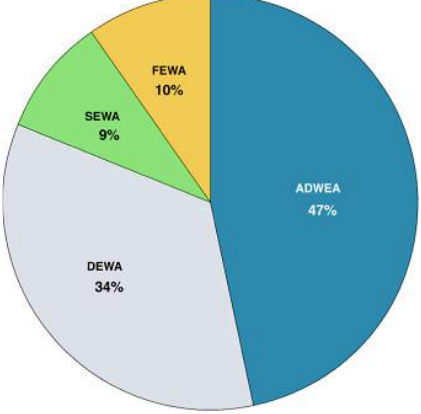
Figure 4. Annual electrical consumption by UAE authorities in